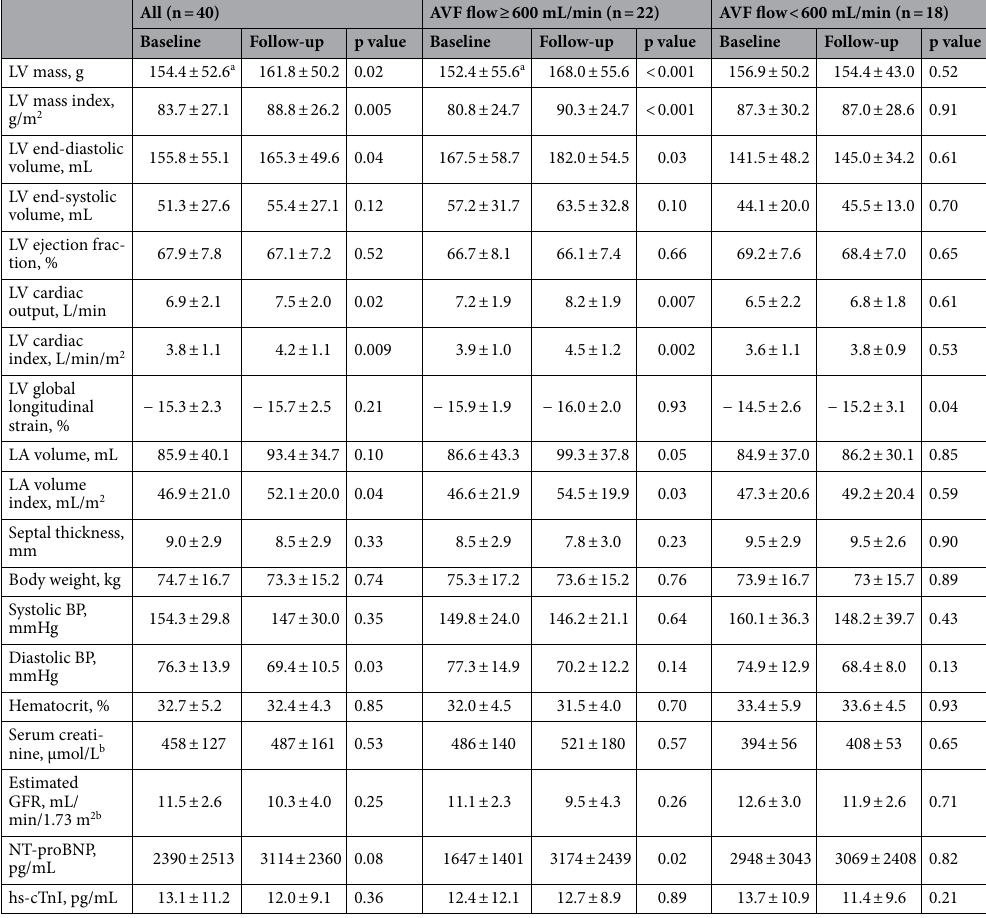
Table 2. Summary of changes in cardiac magnetic resonance-derived cardiac indexes, clinical and laboratory parameters. AVF arteriovenous fistula, LA left atrial, LV left ventricular, BP blood pressure, GFR glomerular filtration rate calculated using Chronic Kidney Disease Epidemiology Collaboration (CKD EPI) formula, NT-proBNP N-Terminal-pro B-type Natriuretic Peptide, hs-cTnI high-sensitivity cardiac Troponin I. a Plus- minus values are mean ± SD. b Includes 23 non-dialysis